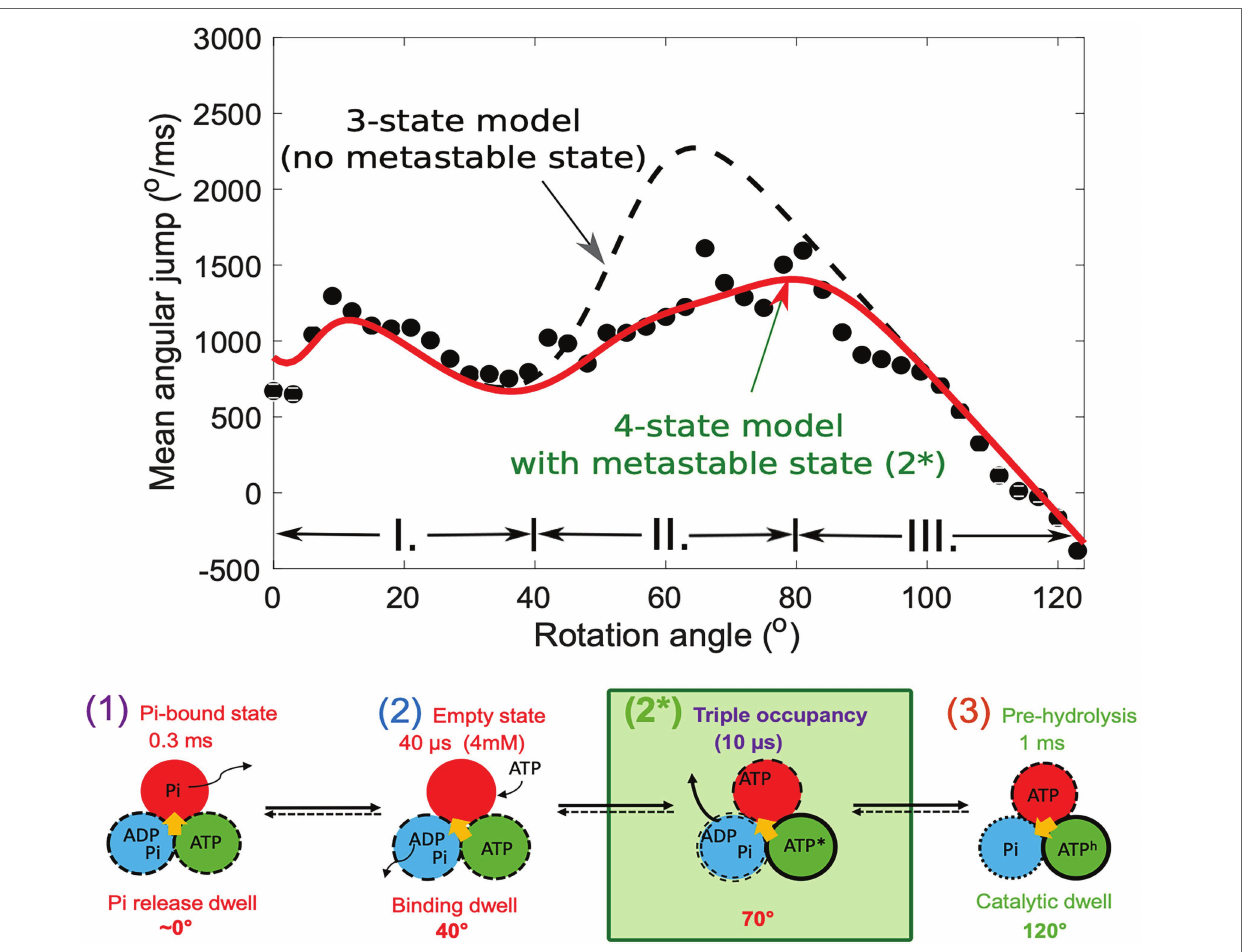
FIGURE 4 | Mean angular jump as a function of rotation angle (top) in fast rotation trajectories. Black dots indicate experimental points, the dashed line shows the predictions from a three-state model, and the continuous line was calculated assuming a fourth state. It is a three-occupancy state. The ATP* and ATP h indicate that the ATP in the pocket is in different environments sue to conformational changes in their host subunits. The figure was reproduced from Volkán-Kacsó et al.